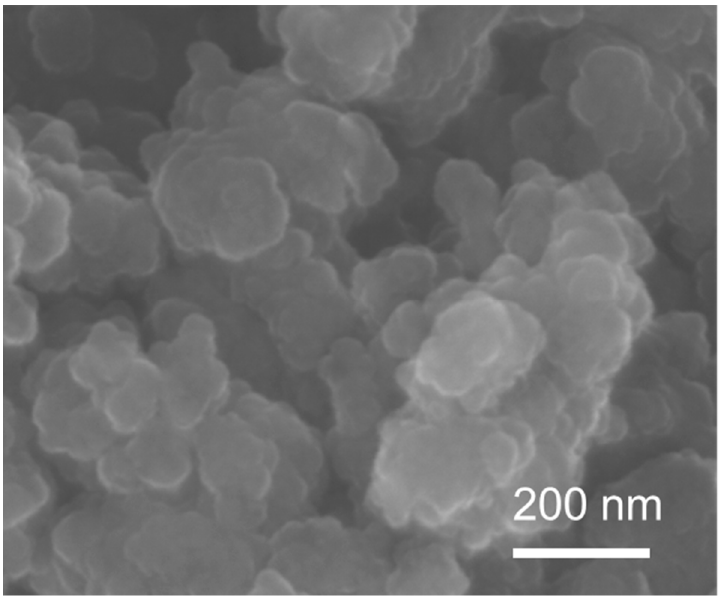
Figure 13. SEM images of used (19 h of CO 2 methanation) AMO-Ni 3 Al 1 -CO 3 -LDO catalyst.